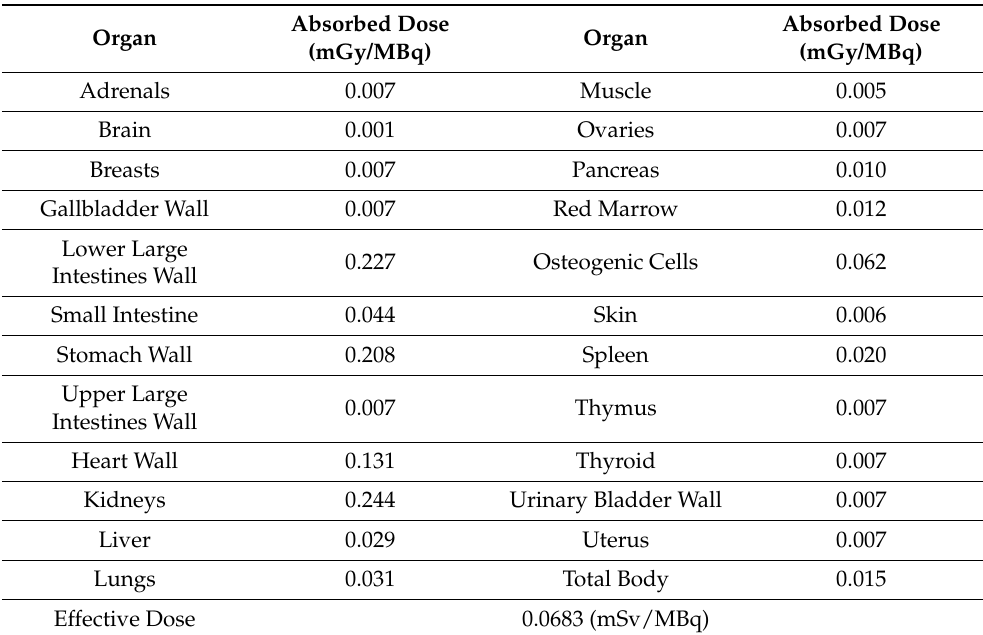
Table 2. Calculated absorbed dose (mGy/MBq) for 188 Re-ZHER2:41071 in humans using OLINDA/EXM 1.0. OLINDA/EXM